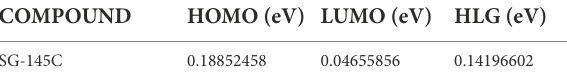
TABLE 2 DFT calculation of